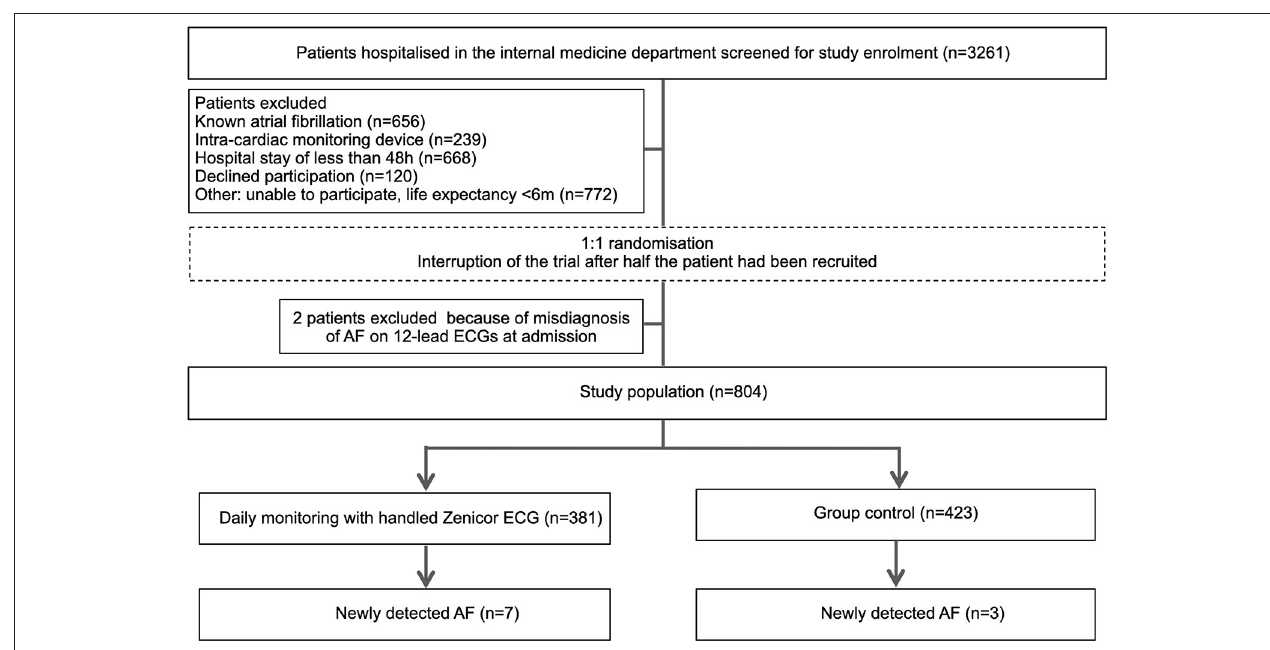
FIGURE 1 | Study flowchart. Participants are 1:1 randomized to either handheld single-lead ECG (Zenicor) screening or control group.